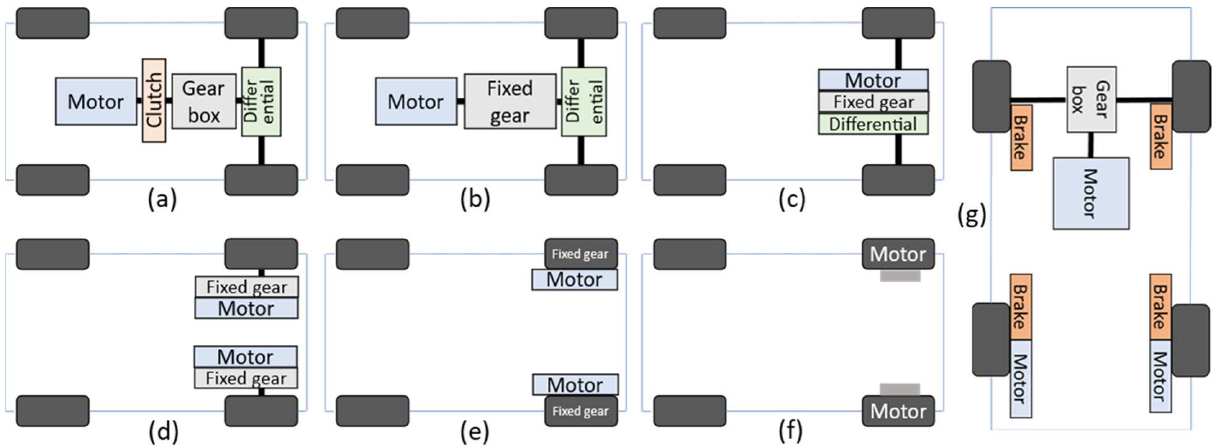
Figure 1. Various configurations of electric vehicle traction systems. ( a ) Conventional with clutch, ( b ) conventional without clutch, ( c ) conventional integrated, ( d ) close-to-wheel drive, ( e ) in-wheel indirect drive, ( f ) in-wheel direct drive [5], ( g ) Combined conventional without clutch and in-wheel motor drive [6].